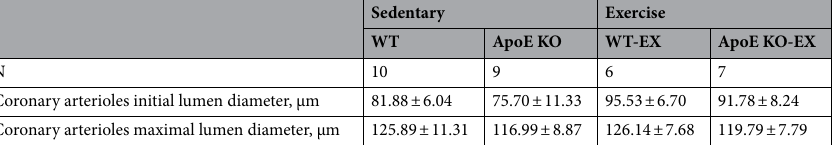
Table 1. Vessel characteristics. The initial lumen diameter and maximal lumen diameter of coronary arterioles were measured at 24–25 weeks of